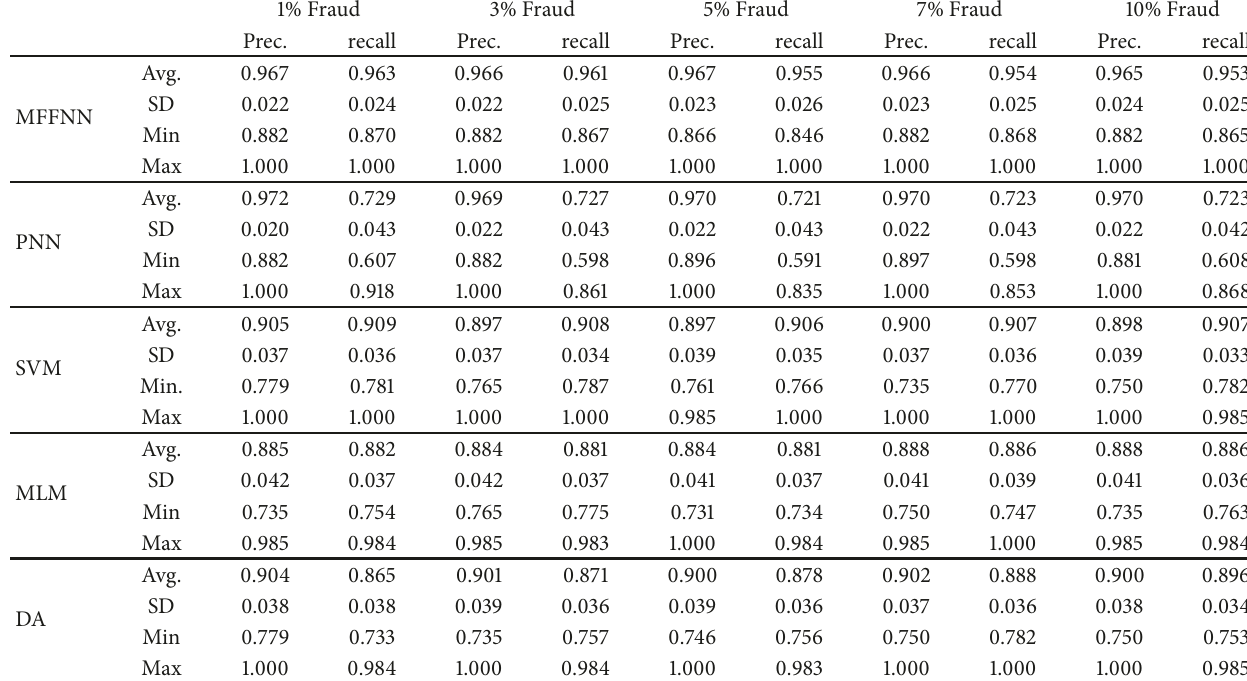
and for training sample size of 500 and test sample size of